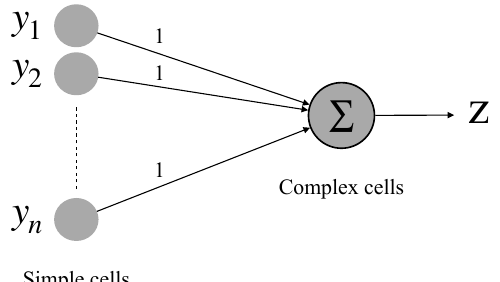
Figure 9. Realization of a complex cell.